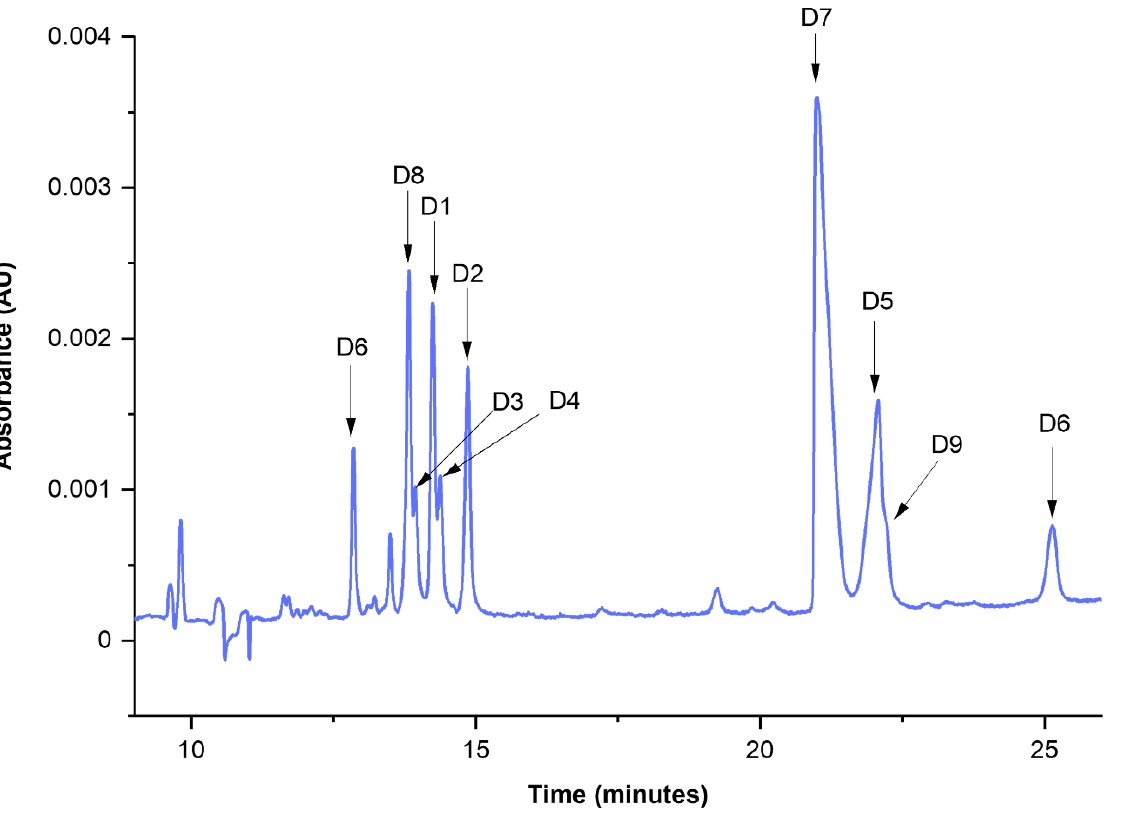
Figure 2. Microemulsion electrokinetic capillary chromatography (MEEKC) separation of 9 dye standards (D1–D9) accomplished in optimal conditions (analytical wavelength—220 nm, background electrolyte (BGE) — ME8.1).